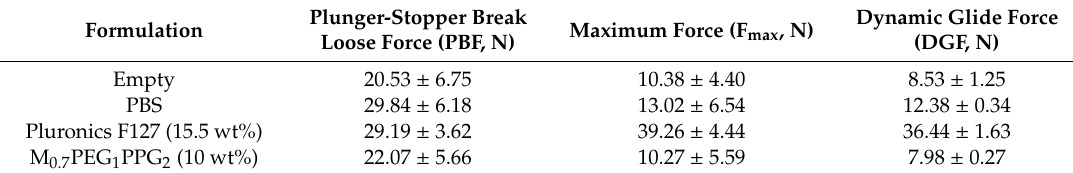
Table 2. Dynamic glide forces, plunger-stopper break-loose forces and maximum forces determined